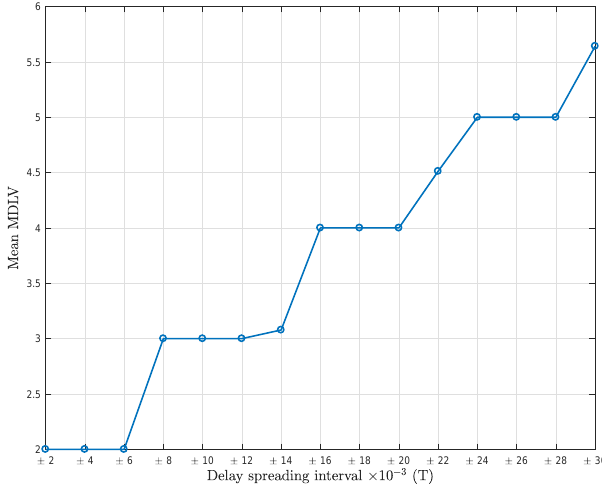
Figure 3. Mean value of the minimum description length (MDL) criterion (mean MDLV ) vs. delay spreading; P l = 20, K = 64, SNR = 5 dB, mean MDLV values are obtained from 500 independent simulations each.